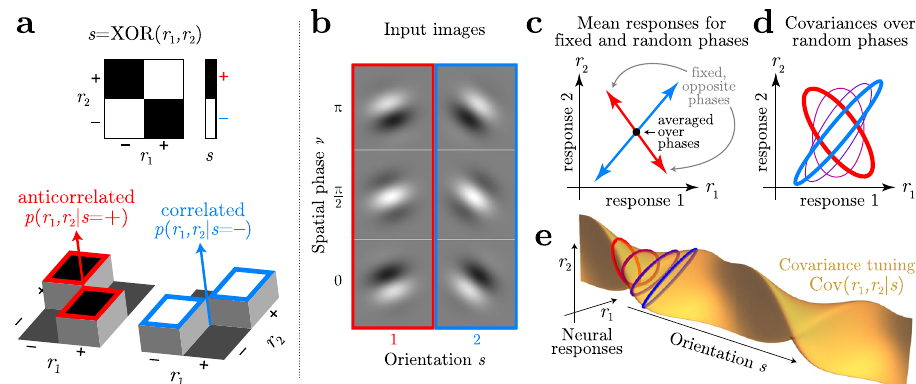
Fig. 2 Nonlinear codes. a Simple example in which a stimulus s is the XOR of two neural responses (top). Conditional probabilities p ( r 1 , r 2 ∣ s ) of those responses (bottom) show they are anti-correlated when s = + 1 (red) and positively correlated when s = − 1 (blue). This stimulus-dependent correlation between responses creates a nonlinear code. The remaining panels show that a similar stimulus-dependent correlation emerges in orientation discrimination with an unknown spatial phase. b Gabor images with two orientations and three spatial phases. c Mean responses of linear neurons with Gabor receptive fi elds are sensitive to orientation when the phase is fi xed (arrows), but point in different directions for different spatial phases. When phase is an unknown nuisance variable, this mean tuning, therefore, vanishes (black dot). d The response covariance Cov( r 1 , r 2 ∣ s ) between these linear neurons is tuned to orientation even when averaging over spatial phase. Response covariances for four orientations are depicted by ellipses. e A continuous view of the covariance tuning to orientation for a pair of neurons.